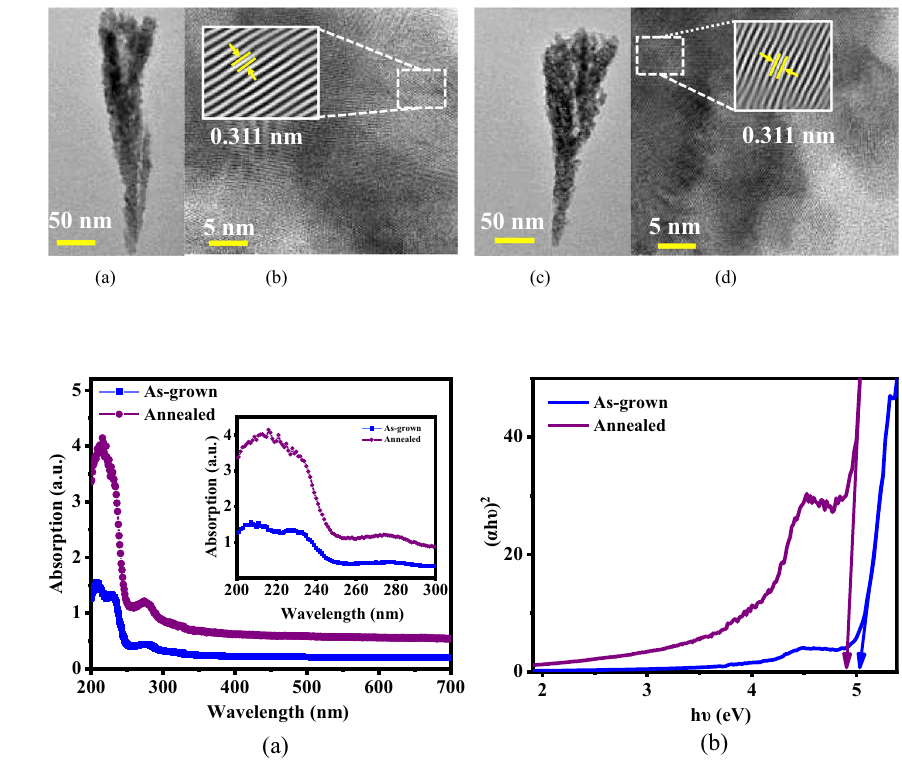
Fig. 4 a Single as-grown Gd O NR b HRTEM image of 2 3 as-grown Gd image of annealed Gd